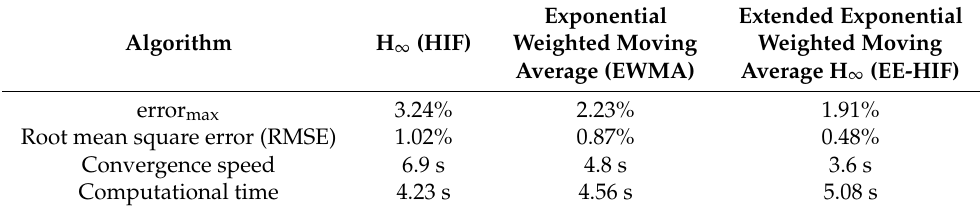
Figure 9. The estimation error curve of the three algorithms. Table 1. The different performance indicators of each